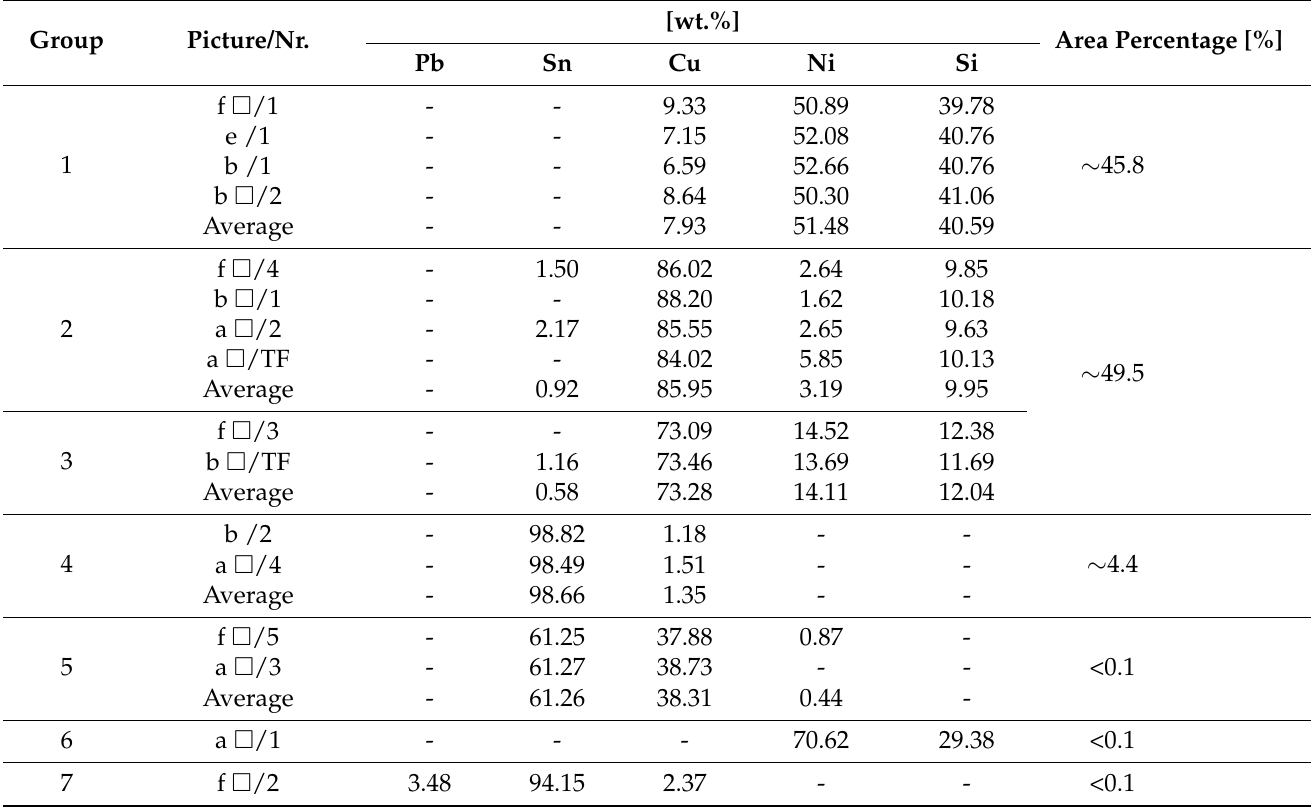
Table 5. Results of the phases composition within a silicide